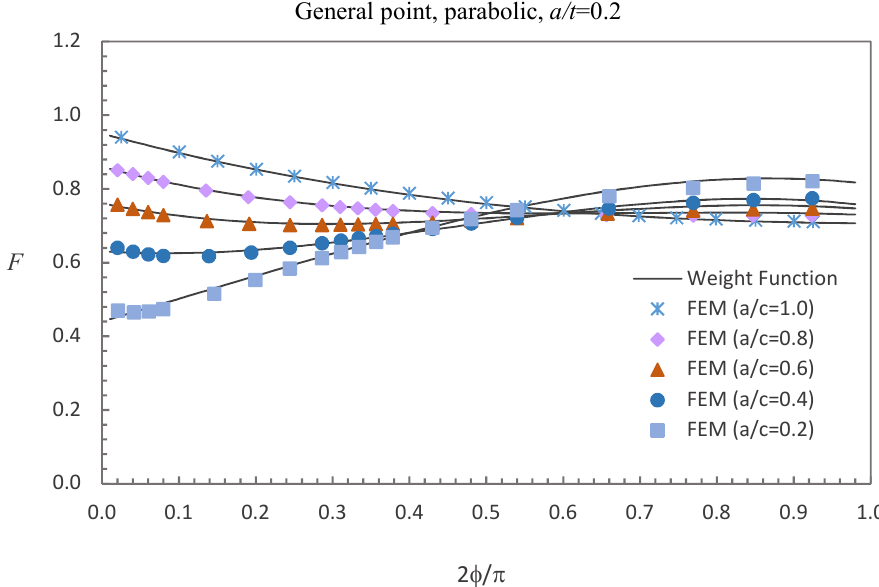
Figure 7. Comparison of weight function and FE results in this study with parabolic stress distribution (general point).